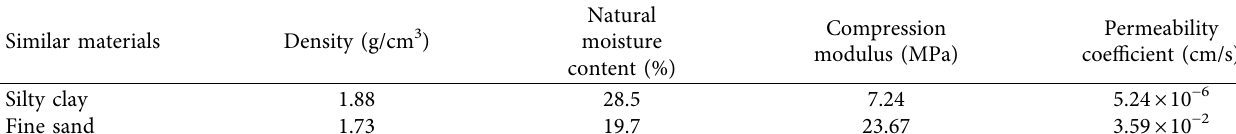
Table 2: Test material